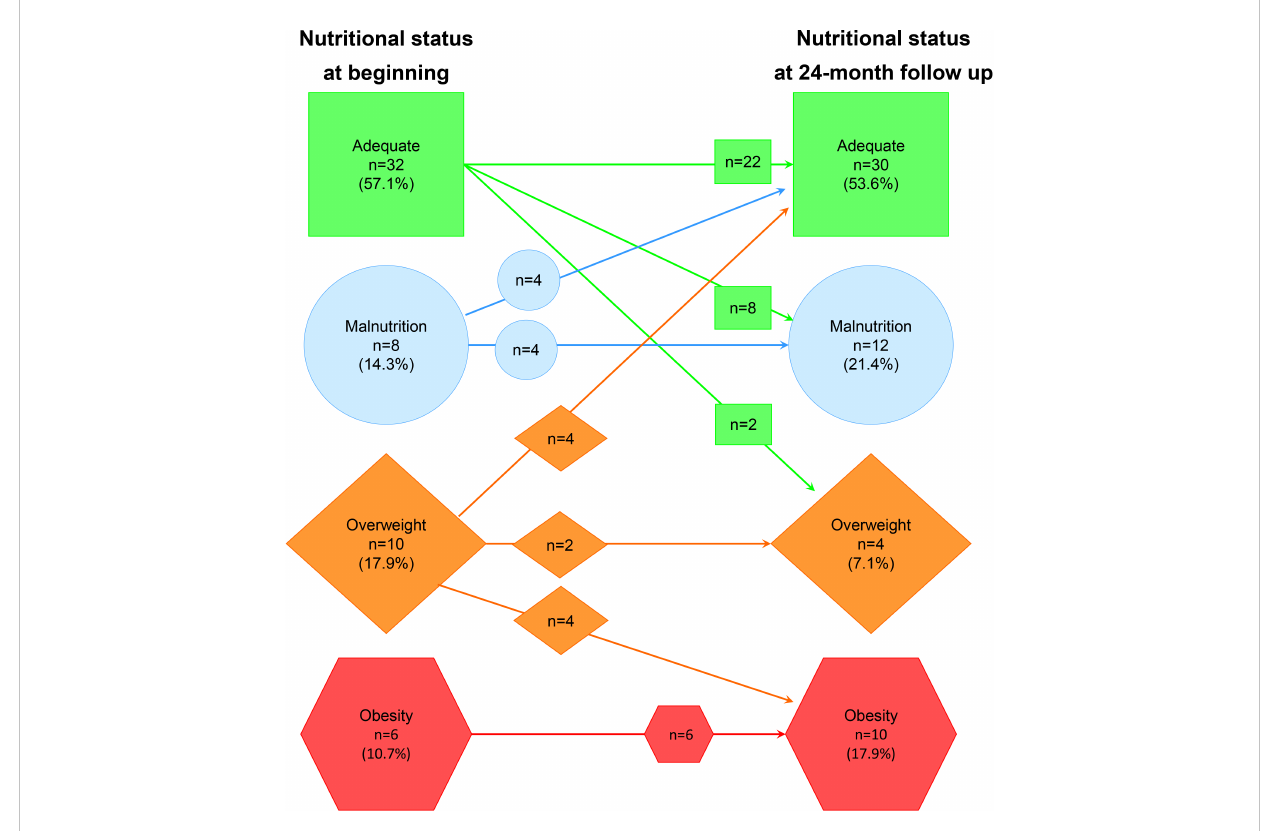
FIGURE 1 Change in nutritional status from baseline to 24 months of follow-up in chronic kidney disease pediatric